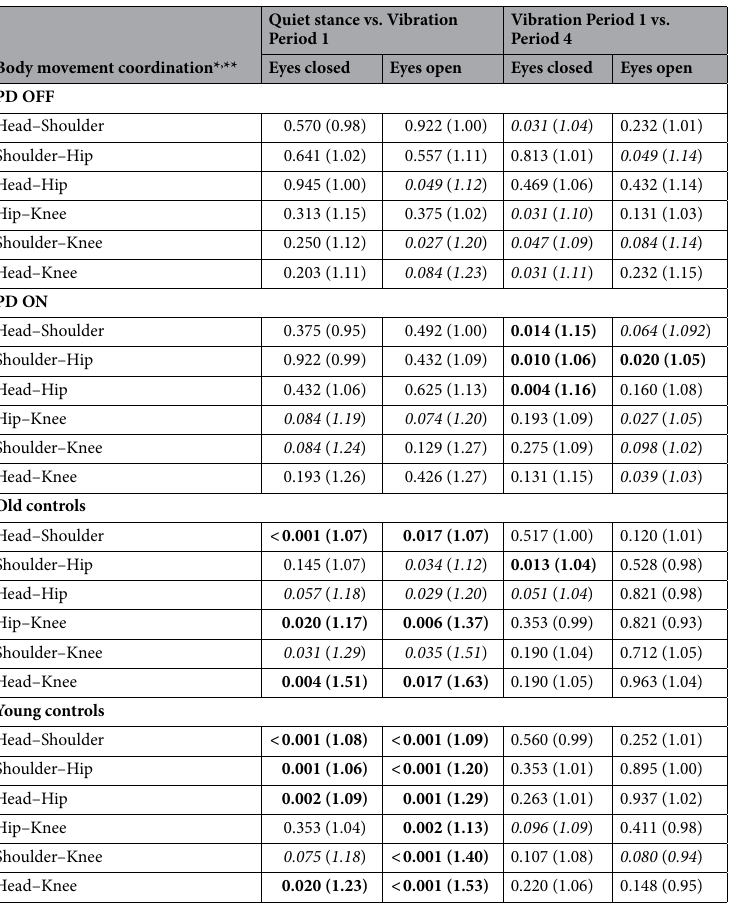
Table 4. Movement pattern changes in different groups and conditions between quiet stance and vibration period 1 and between vibration period 1 and period 4 during tests with eyes closed and eyes open. *The quotient value between quiet stance and period 1 and between period 1 and period 4 are presented within the parenthesis. A quotient value above 1 signifies an increased synchronicity between the movements made at body sites compared. **Bonferroni corrected significant differences are marked with bold numbers and trends (p < 0.1) are marked with italics